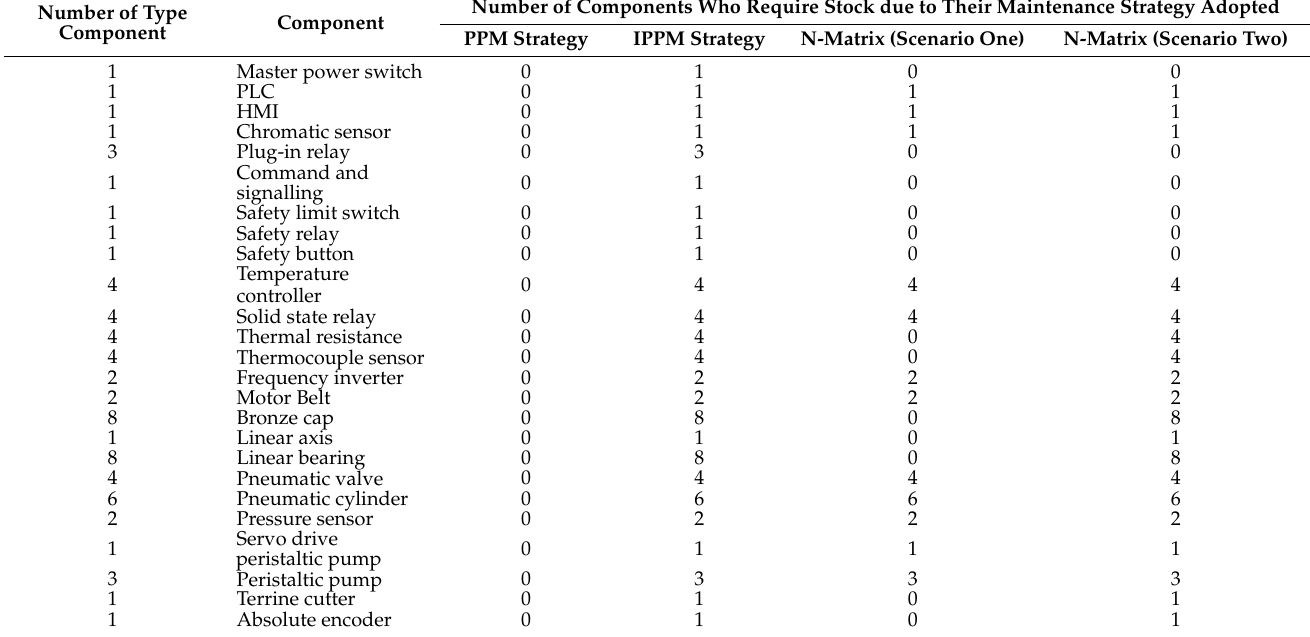
Table 17. Comparing the number of type of components that require stock due to the maintenance strategy adopted.